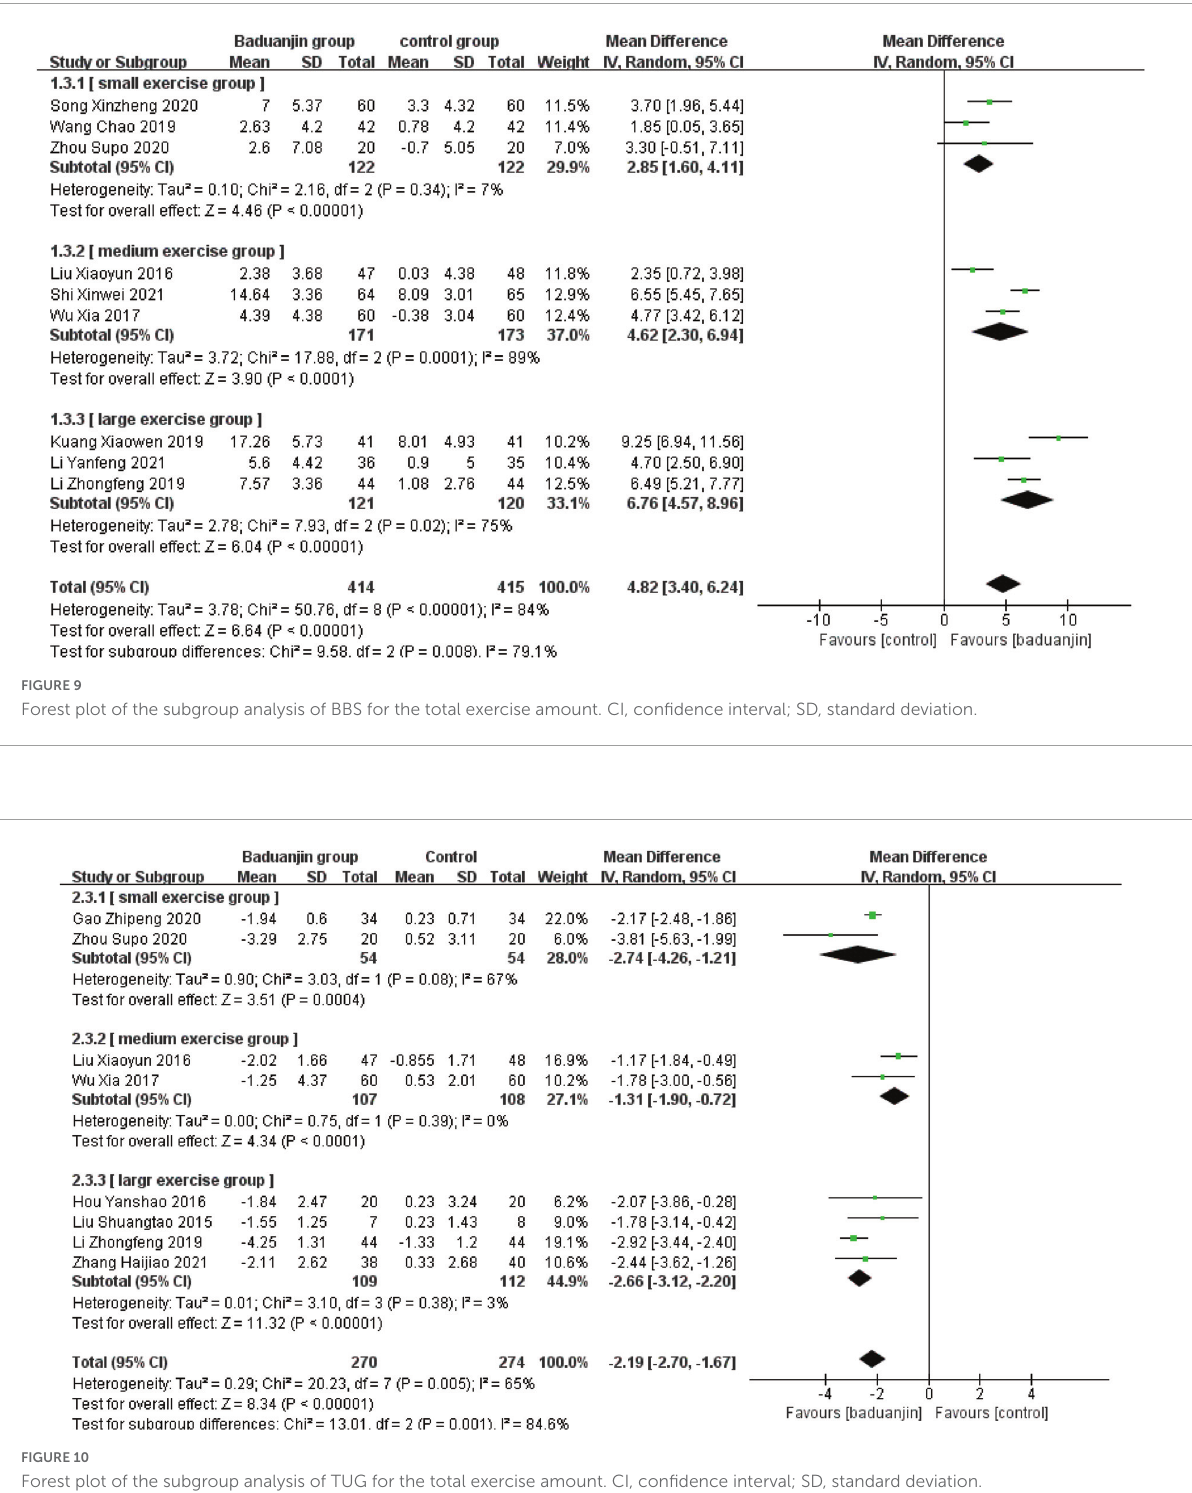
and extension muscle strength, with the subject’s vision blocked. BBS and TUG were shown to have good reliability and validity in previous research (30, 31). Comparatively,